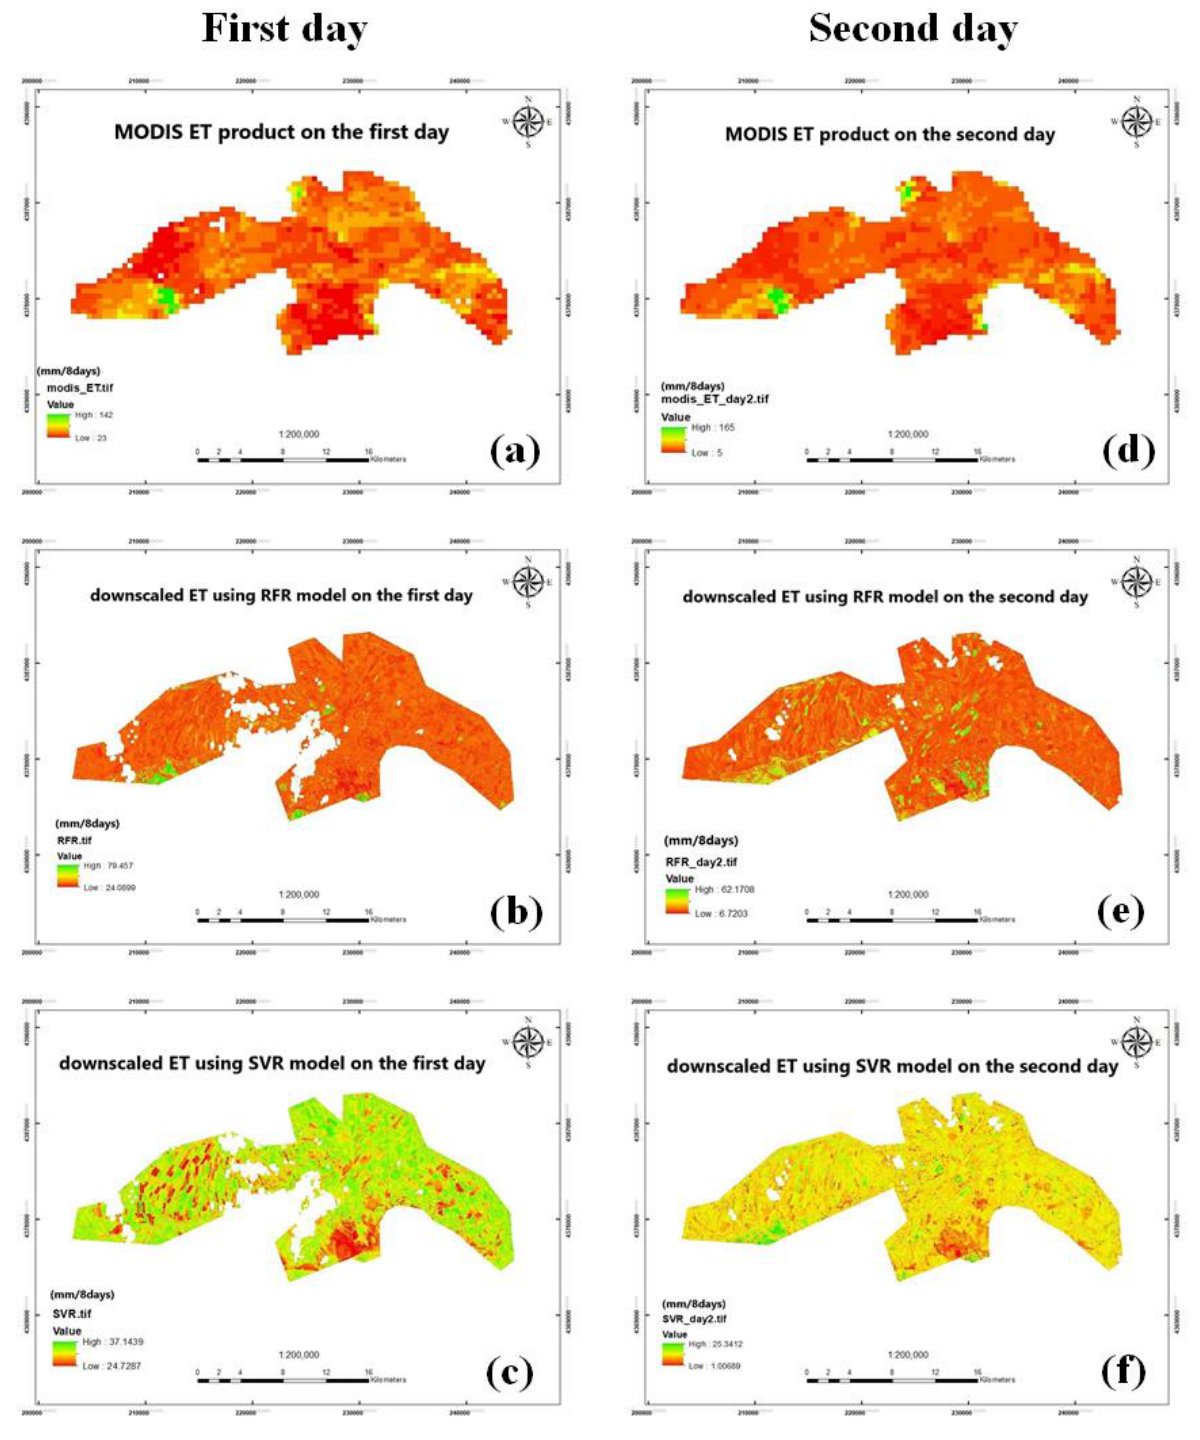
Figure 6. (a) and (d) MODIS 8-day ET for the first and second day, respectively, (b) and (e) Downscaled Landsat 30 m ET for the first and second day using RFR model, and (c) and (f) Downscaled Landsat 30 m ET for the first and second day using SVR model. Ke et al. (2016) illustrated that indices including, EVI, NDVI, parameters in modelling in the current study, and the and SAVI which are known as vegetation growth-related were importance of the NDWI parameter as an input for ET among the most predominant in 8-day ET modelling by RF estimation was emphasized in the research of Morse et al algorithm. However, NDIIb7 and NDWI had moderately lesser (Mosre et al., significance. Also, LST which is an indicator of temperature had less significance than either vegetation greenness or wetness indicators. Also, two Landsat-8 indices related to water content, NDMI and NDWI, were identified as important